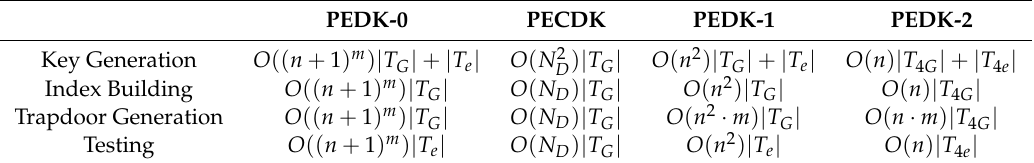
Table 2. Comparison with the previous schemes in time complexity.